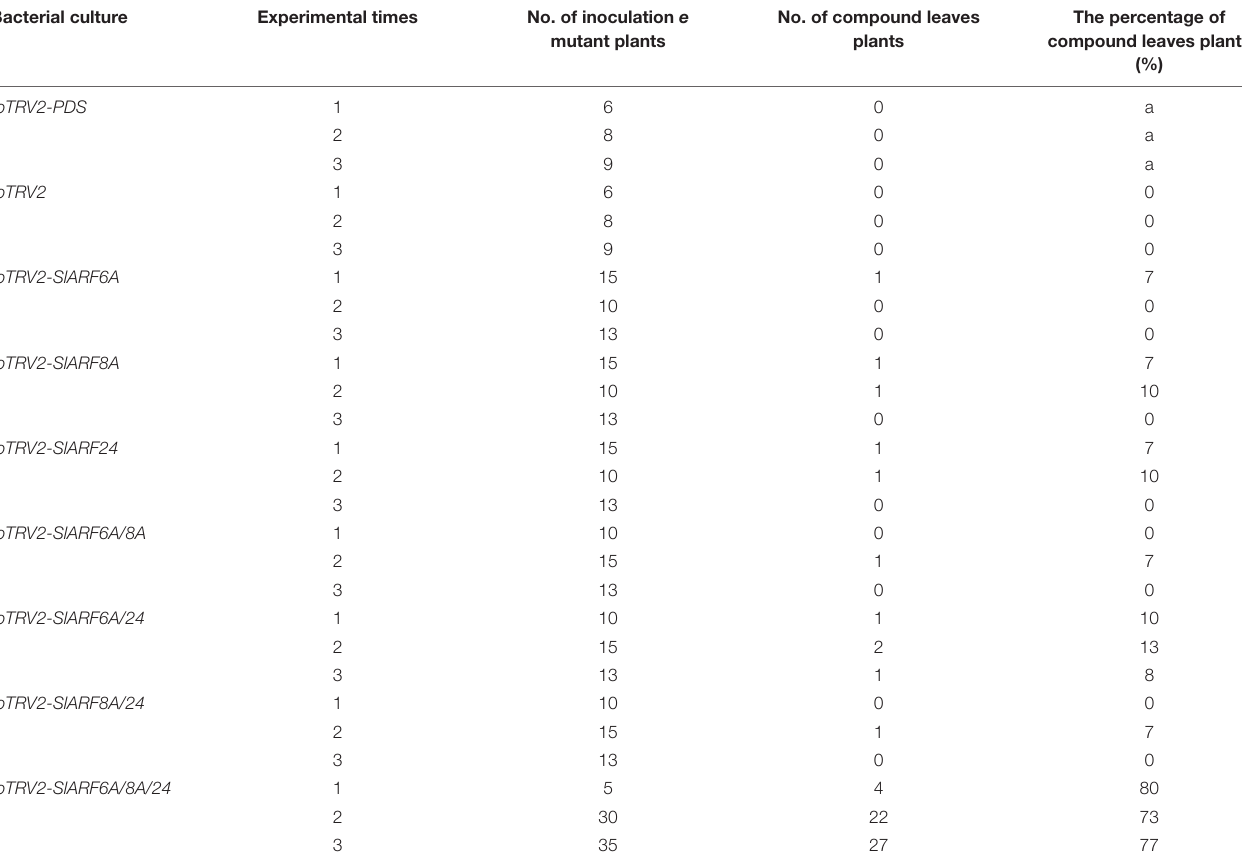
TABLE 1 | Statistical information describing the TRV-mediated virus-induced gene silencing (VIGS) of genes in e mutant plants. Bacterial culture Experimental times No. of inoculation e